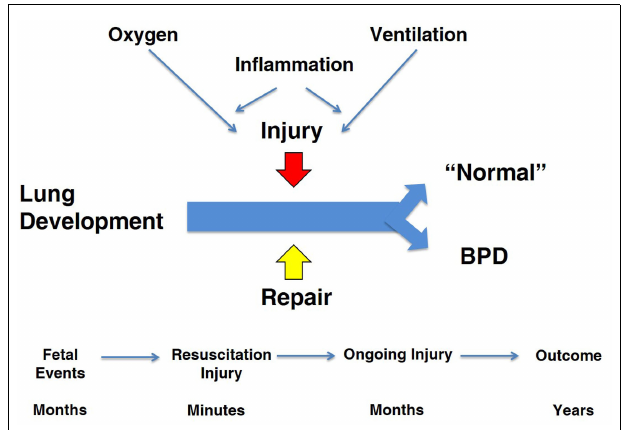
FIGURE 1 | Overview of “big events” in pathophysiology of BPD . The three major programs that are active during the course of BPD are lung development, injury, and repair. The major injuries are from oxygen and ventilation-associated inflammation. The time line for the fetus and infant occurs over months to years, which contrasts to studies in term rodent